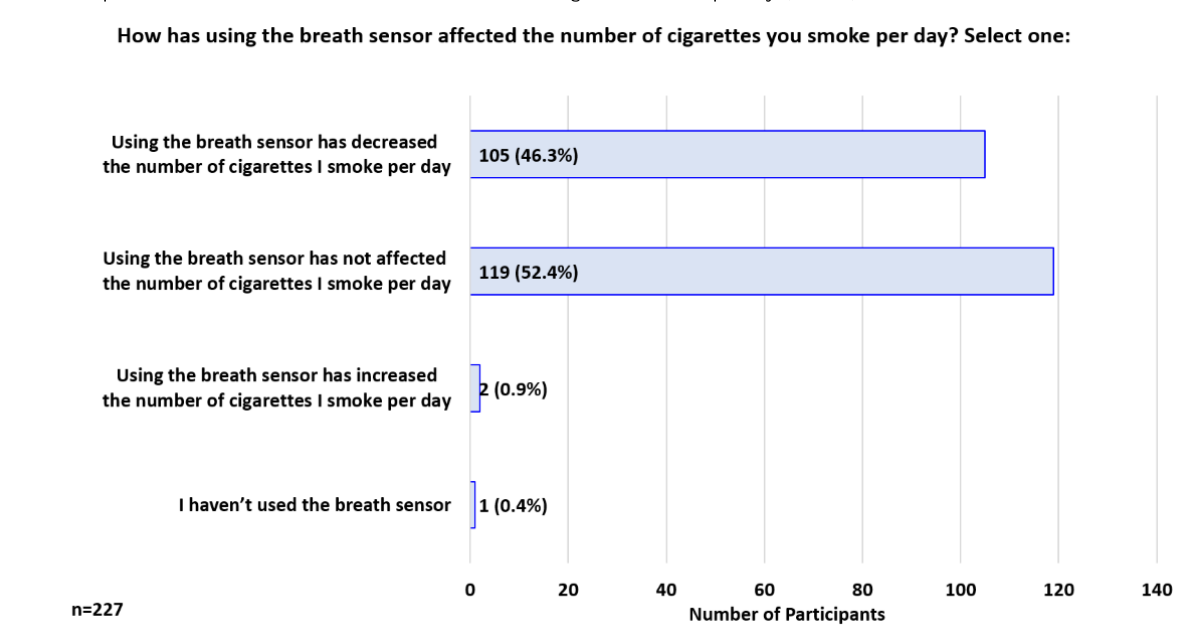
Figure 7. Participant Feedback: Effect of breath sensor on number of cigarettes smoked per day (week